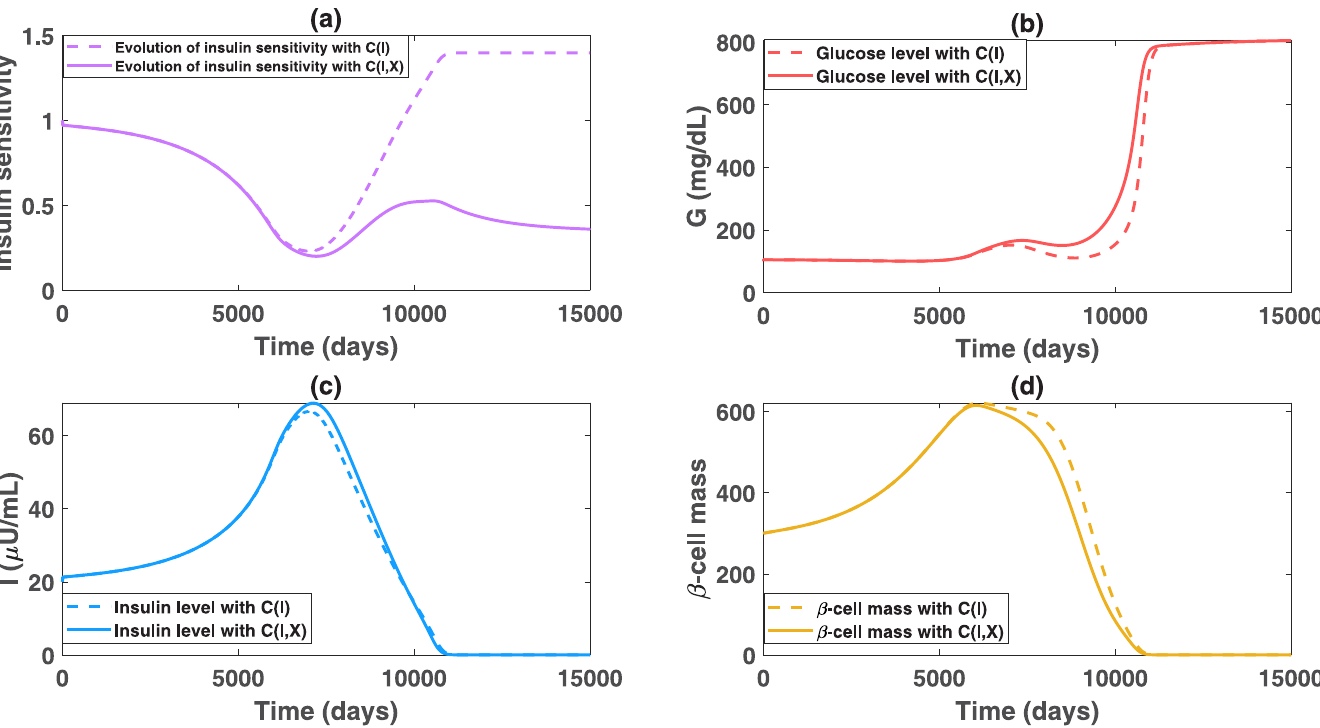
� � , where C X 4 þ 0 : 5 4